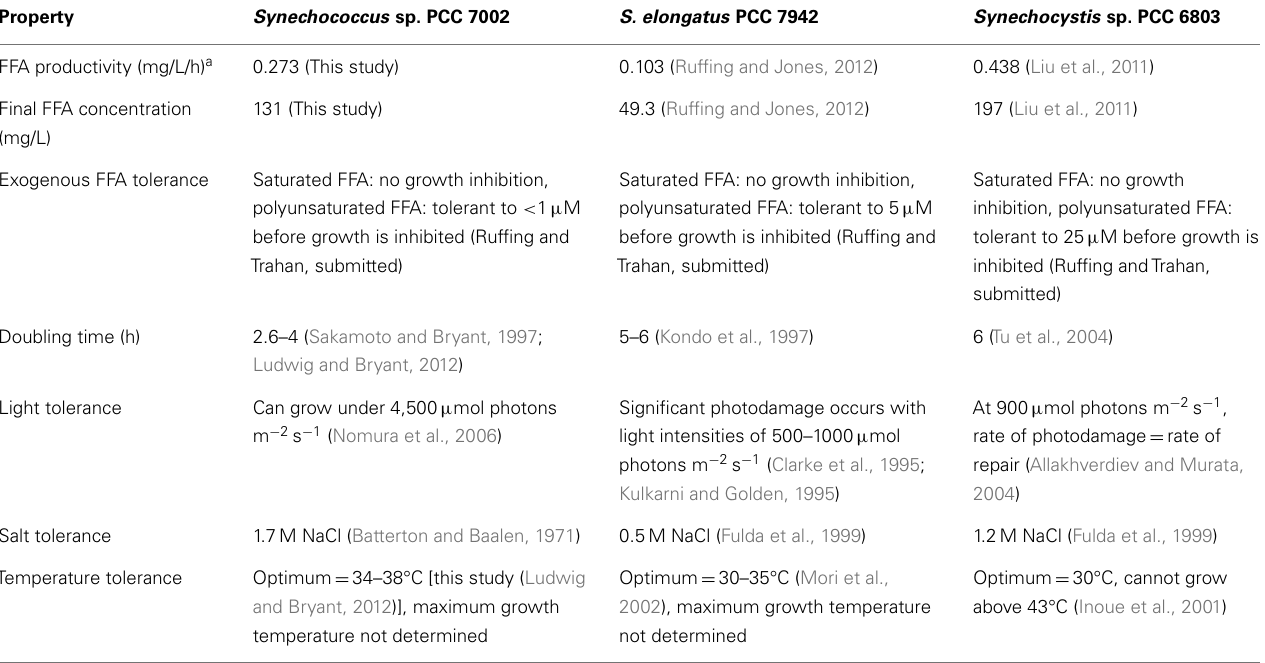
Table 2 | Comparison of FFA production and host strain traits of three model cyanobacterial strains